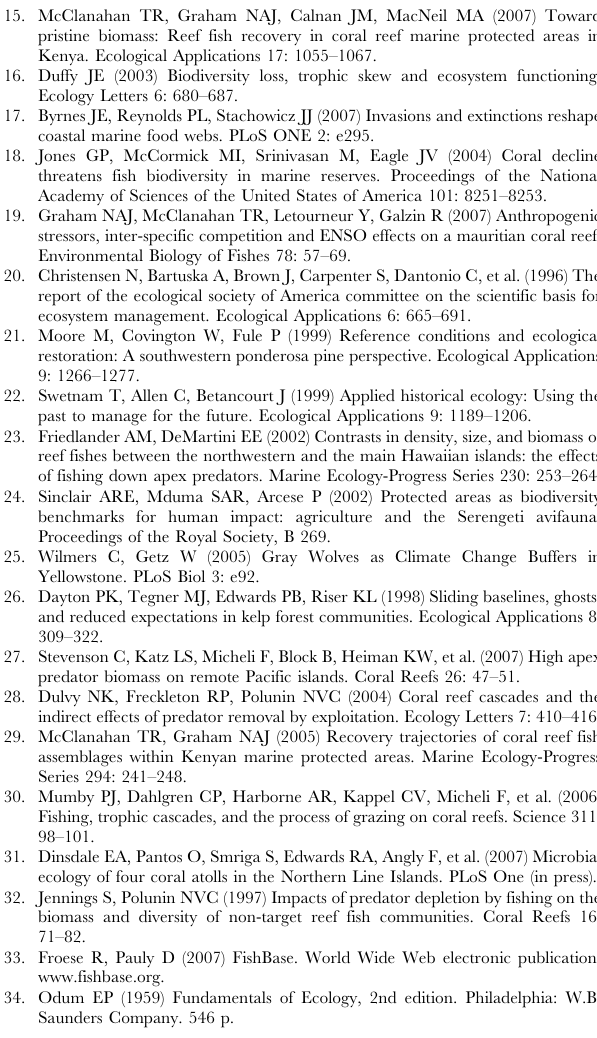
Figure S1 Population data for the northern Line Islands Found at: doi:10.1371/journal.pone.0001548.s006 (0.05 MB TIF) Figure S2 Total annual reef fish catch at Kiritimati Found at: doi:10.1371/journal.pone.0001548.s007 (0.68 MB TIF) Figure S3 Annual Fish Catch for Export on Kiritimati Found at: doi:10.1371/journal.pone.0001548.s008 (0.66 MB TIF)